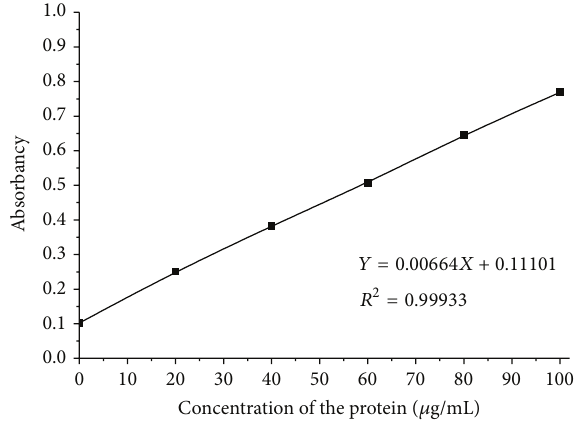
Figure 1: Static reactor. Figure 2: Protein standard